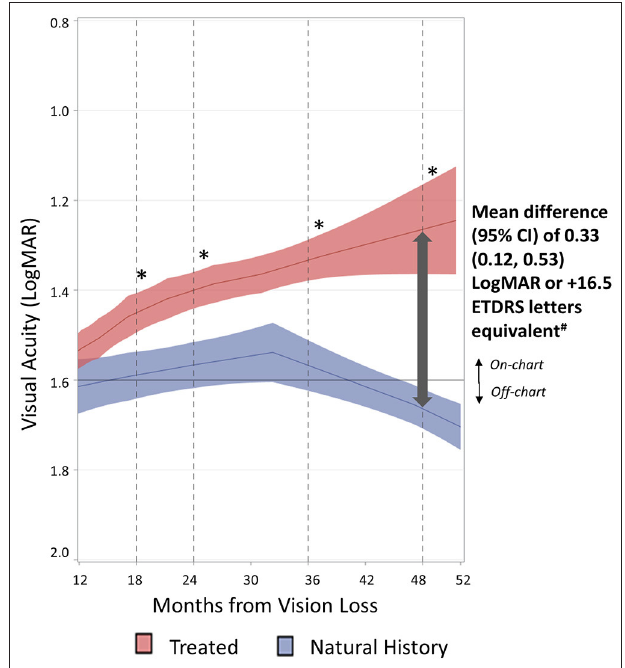
FIGURE 1 | Evolution of visual acuities of treated eyes vs. natural history eyes. The evolution of visual acuities over time for treated eyes ( n = 152) and natural history eyes ( n = 408) was estimated by LOESS regression (solid line) with 95% confidence interval around the fitted curve (shaded area). Smoothing parameter: 0.332 for treated eyes and 0.408 for natural history eyes. *A statistically significant difference between treated and natural history eyes is illustrated by the non-overlapping confidence intervals (CI) of LOESS curves. # Mean differences and 95% CI at month 48 were computed based on a separate analysis described in Table 2